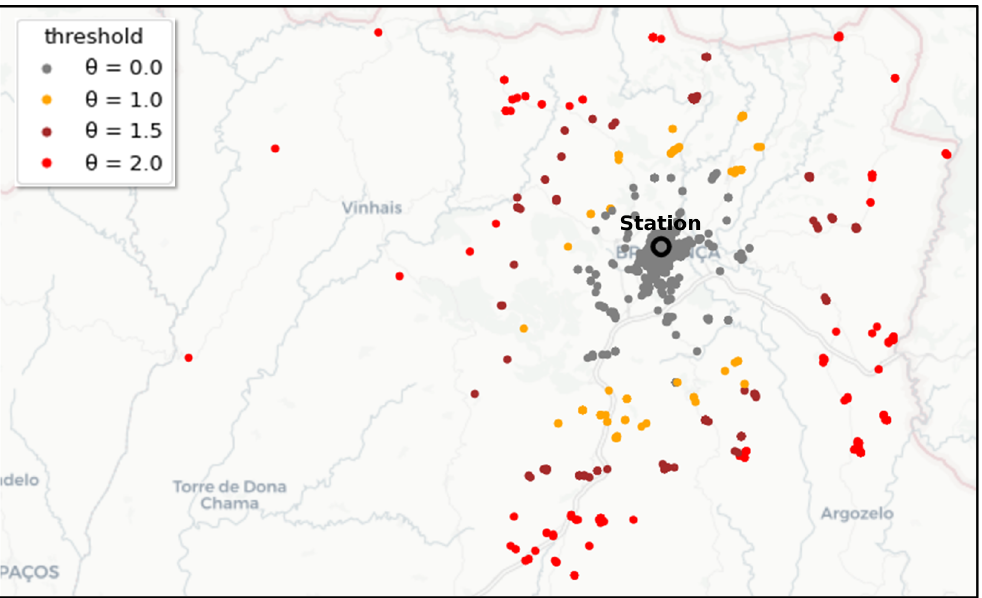
Figure 3. Responses made by a station over a six-month period, showing candidate potential inefficiencies for different values of θ